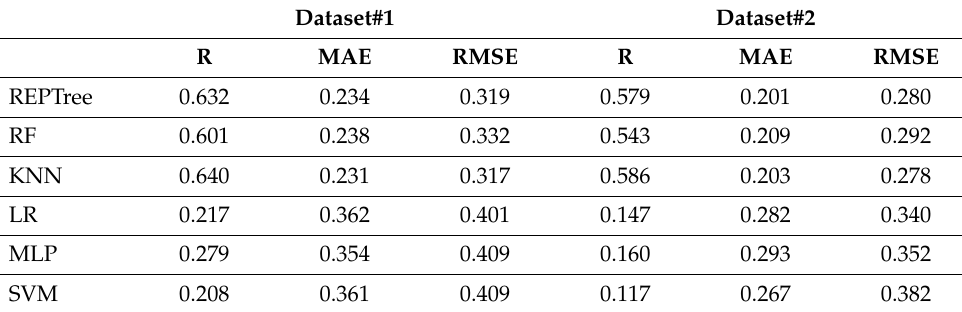
Table 4. Regression analysis results for the TCC metric.